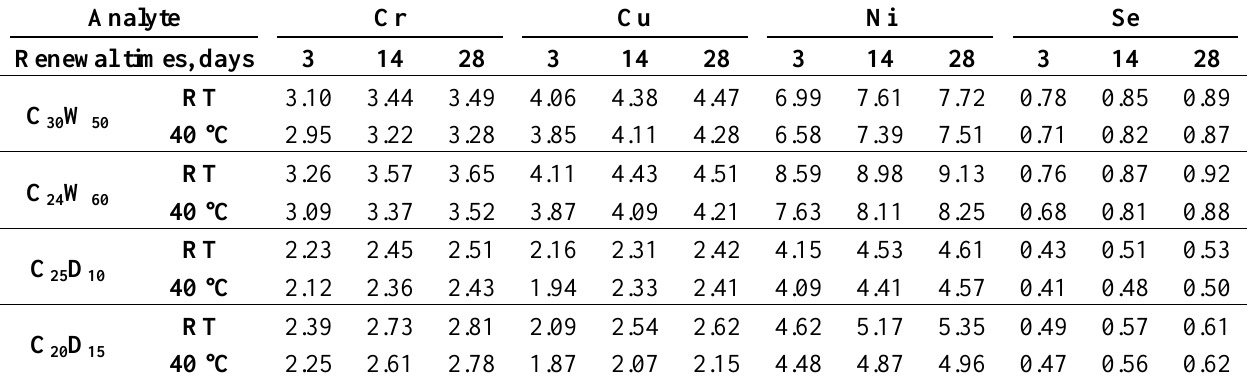
Table 5. Leaching behavior of the aggregates: Heavy metals release, µg/L. Analyte Cr Renewal times,